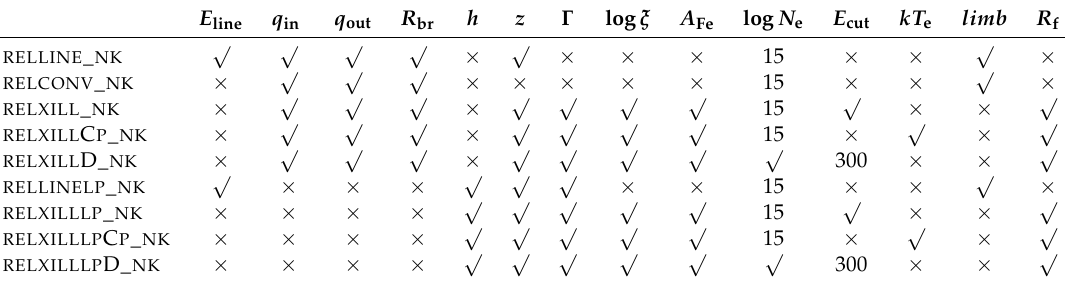
Table 1. List of the available models and the parameters of each model. Parameters that are not listed are the dimensionless spin parameter a ∗ , the inclination angle ι , the inner disk radius R in , the outer disk radius R out , the deformation parameter selector defpar_type , and the deformation parameter √ value defpar_val , as they are included in all models. means the parameter is part of the model and × means it is